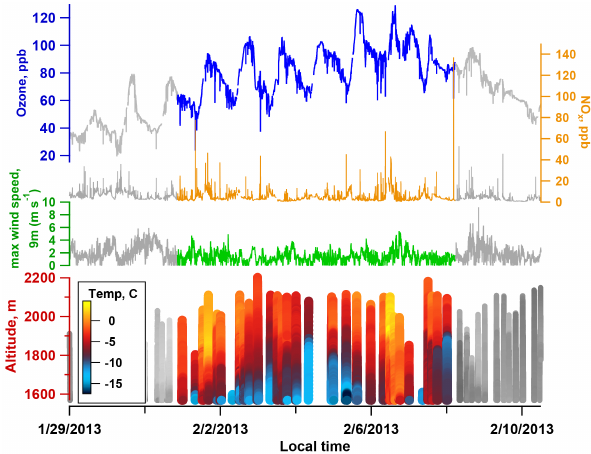
Figure 1. Ozone formation event and analysis period selection. The analyzed period (colored) was selected to avoid high wind events on 31 January and 8 February (center) and include strong temperature inversions (bottom) to minimize mixing of VOCs in or out of the basin. Meteorological data courtesy of NOAA Physical Sciences Division. Temperature data from tethered balloon sonde operated by NOAA Global Monitoring